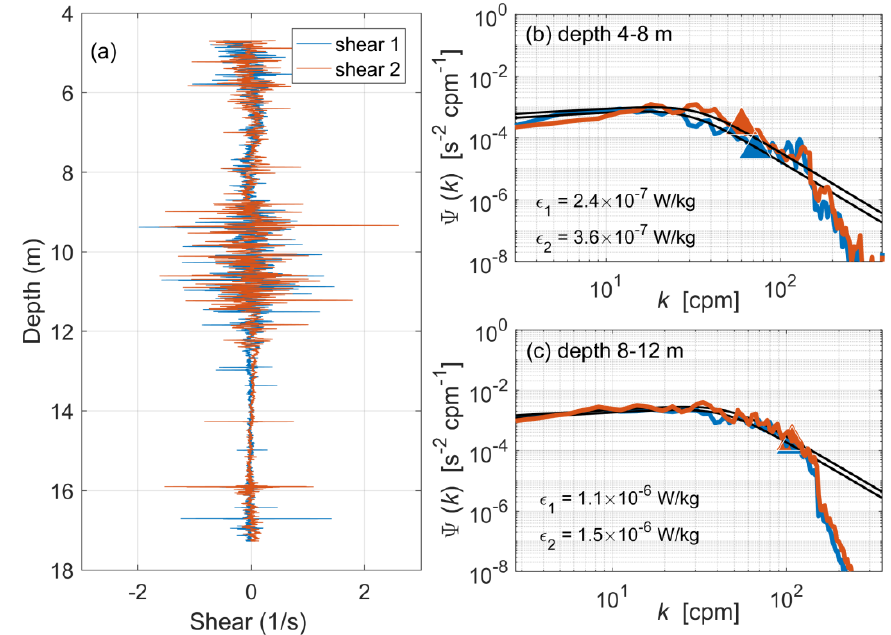
Figure 11. ( a ) Examples of raw microscale velocity shear in specified depth segments during data recording at 12:15 on 21 October 2015 and ( b , c ) the corresponding dissipation spectra. The smooth curves overlapping the dissipation spectra represent the Nasmyth universal spectrum, and triangles indicate the upper limit of integration.